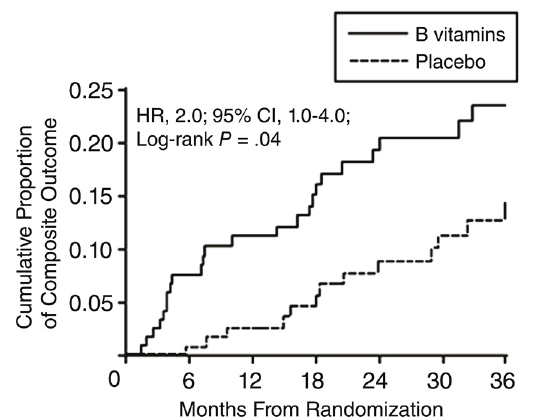
Figure 2. Cumulative proportion of myocardial infarction, stroke, revascularization, and all-cause mortality with high- dose B vitamins in patients with diabetic nephropathy. Diabetic nephropathy patients receiving folic acid 5 mg, B6 25 mg and B12 1,000 μg daily had twice the risk of events compared to patients receiving placebo. All of the events occurred in patients with a glomerular filtration rate of <50 mL/minute/1.73 m² 45 . Reproduced by permission of the American Medical Association from 44.